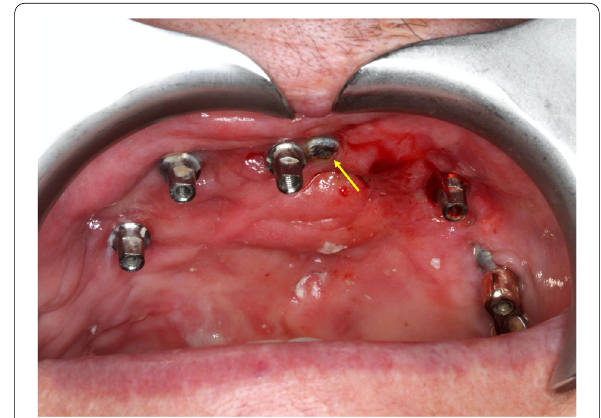
Fig. 5 Partial exposure of the framework. The framework exposure partially (arrow) beside in six out of 21 posts, without any clinical problems apart from mucositis